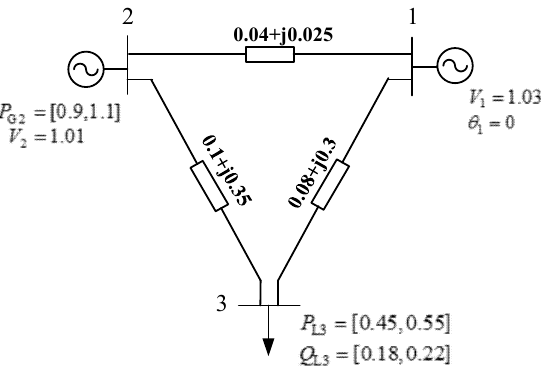
Figure A1. Layout of the three-bus system.